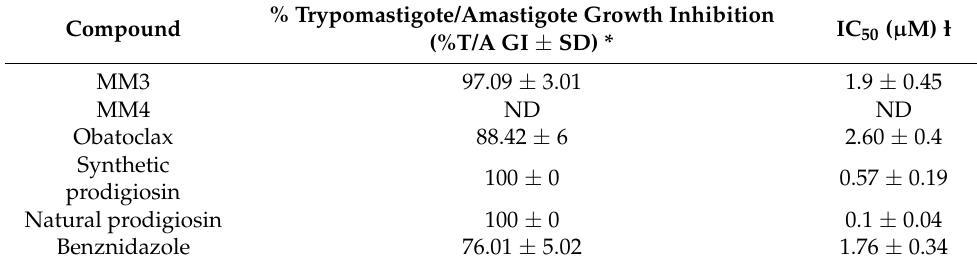
Table 2. Biological activity of tambjamines, Obatoclax, synthetic and natural prodigiosins, and ben- znidazole against trypomastigotes/amastigotes of T. cruzi (CLB strain) at the highest concentration assayed (16 µ M). Compound